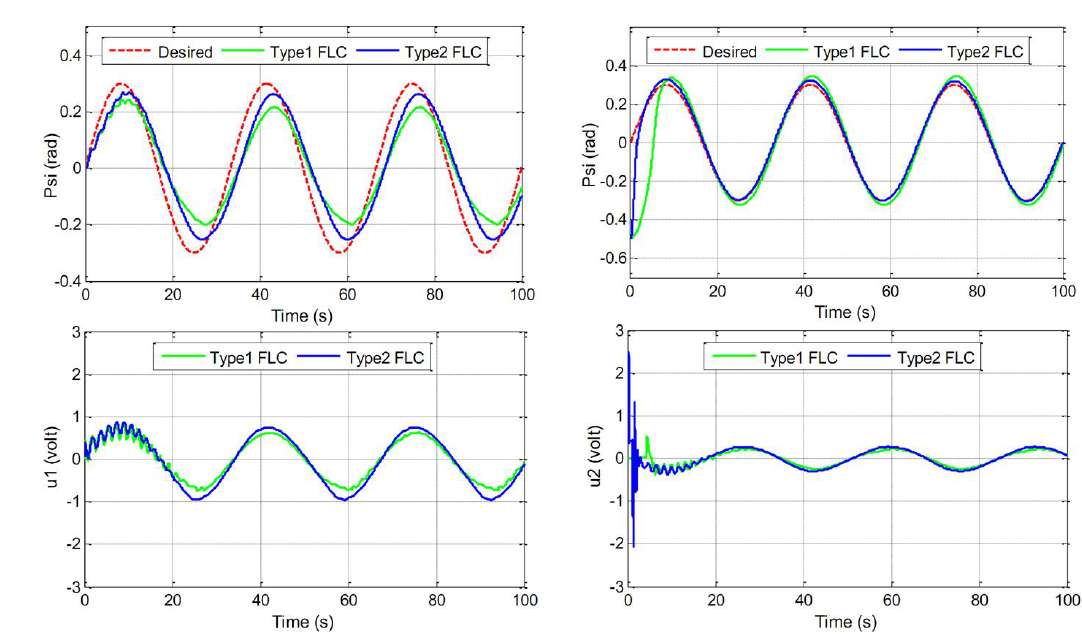
Figure 10. Sine wave responses of the TRMS.